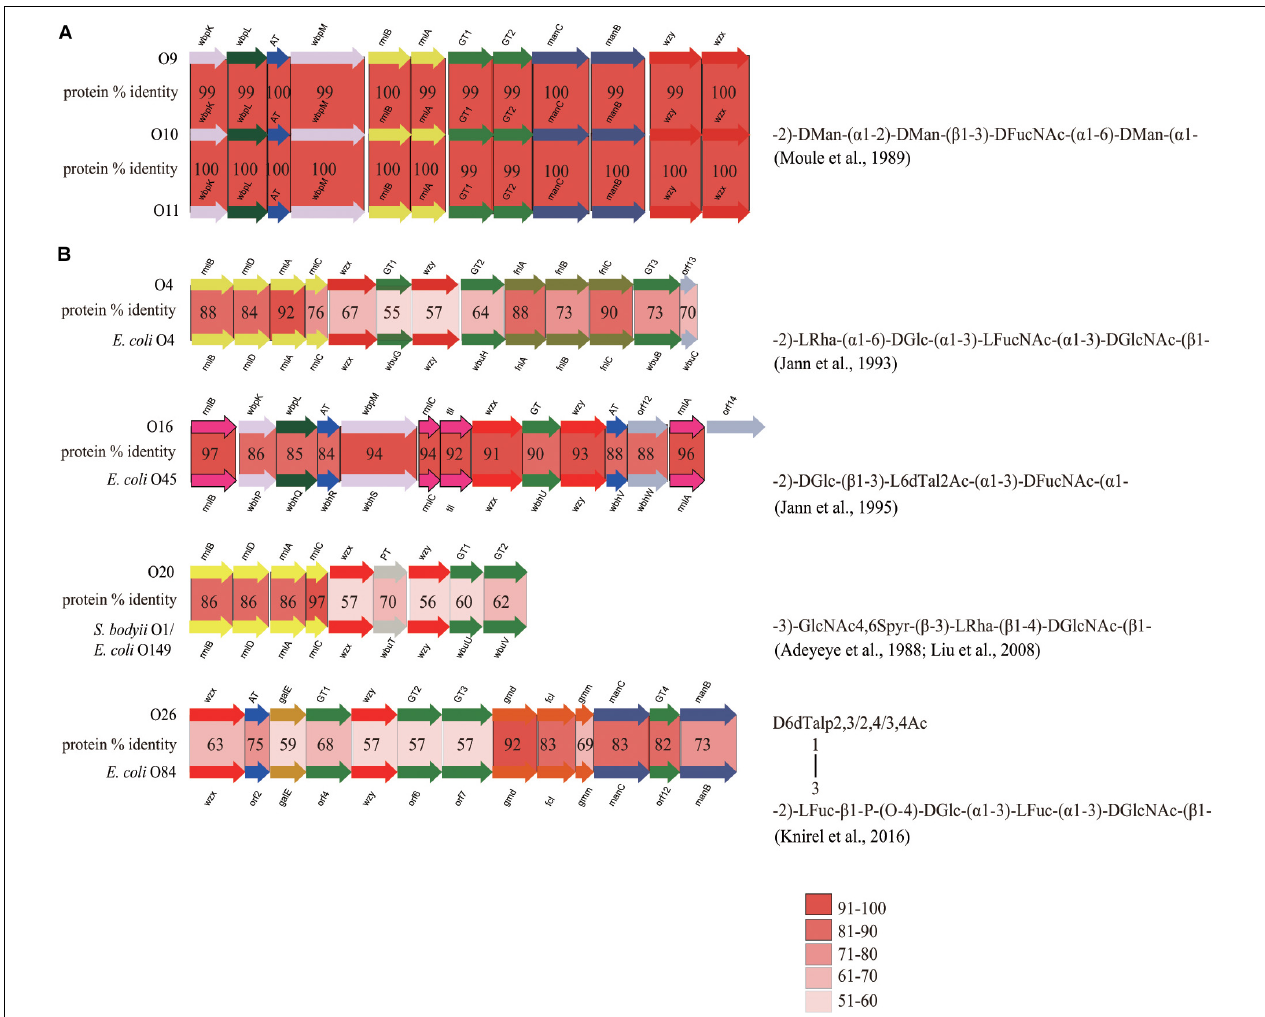
FIGURE 4 | Comparison of closely related O-AGCs within E. cloacae strains and between E. cloacae and E. coli strains. (A) Comparison of O-AGCs of E. cloacae O9/O10/O11, with the O-antigen structure of O10 being shown. (B) Comparison of O-AGCs of E. cloacae O4 and E. coli O4, O16 and E. coli O45, O20 and E.